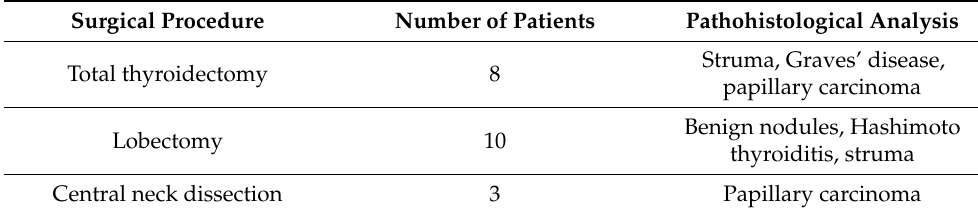
Table 2. Pathohistological diagnosis in patients with different type of surgical